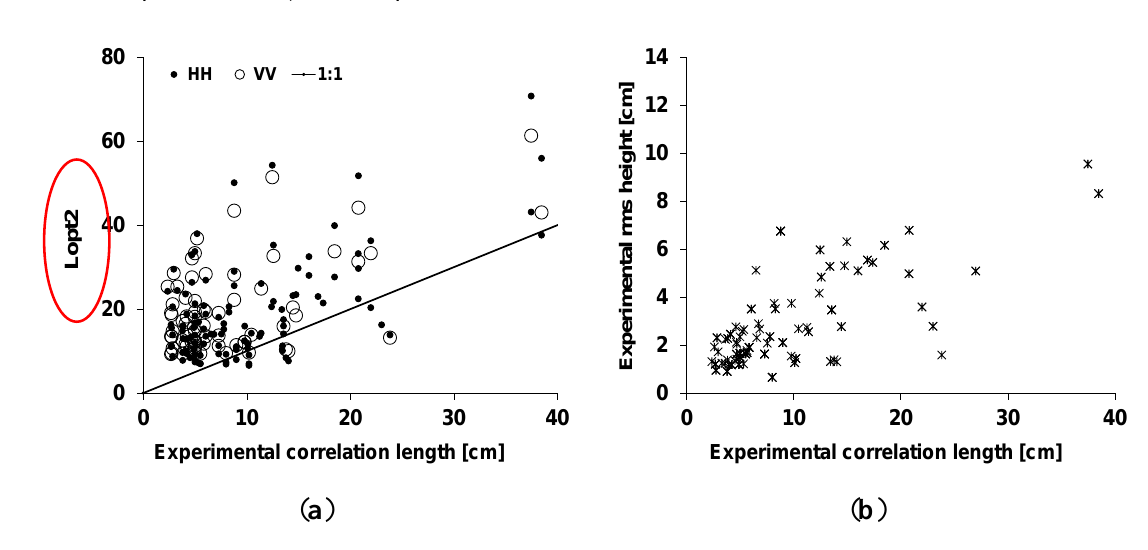
Figure 6. Relationship between ( a ) Lopt2 with Gaussian ACF and the experimental correlation length; ( b ) the root mean square surface height and the experimental correlation length obtained from in situ